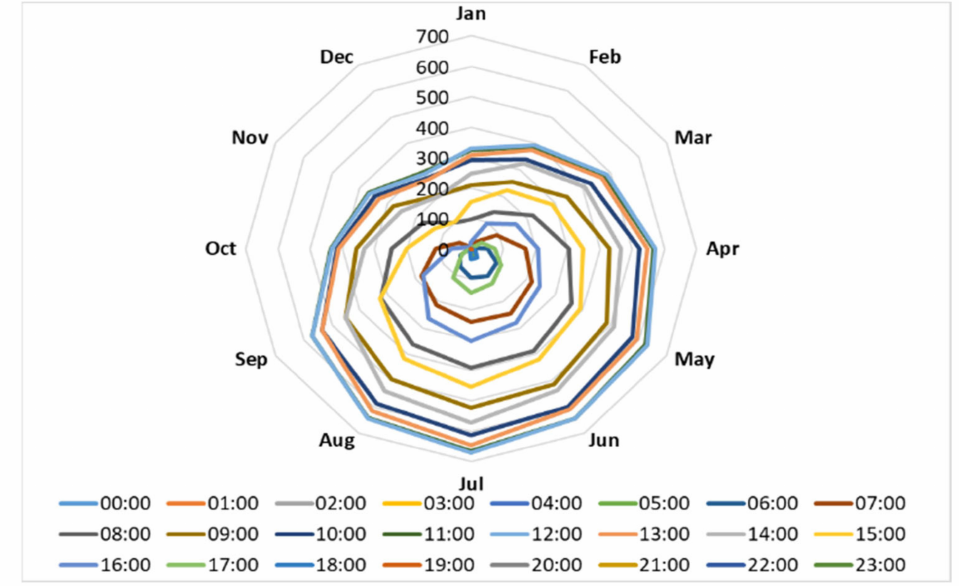
Figure 8. Total produced hourly PV output energy (kWh).